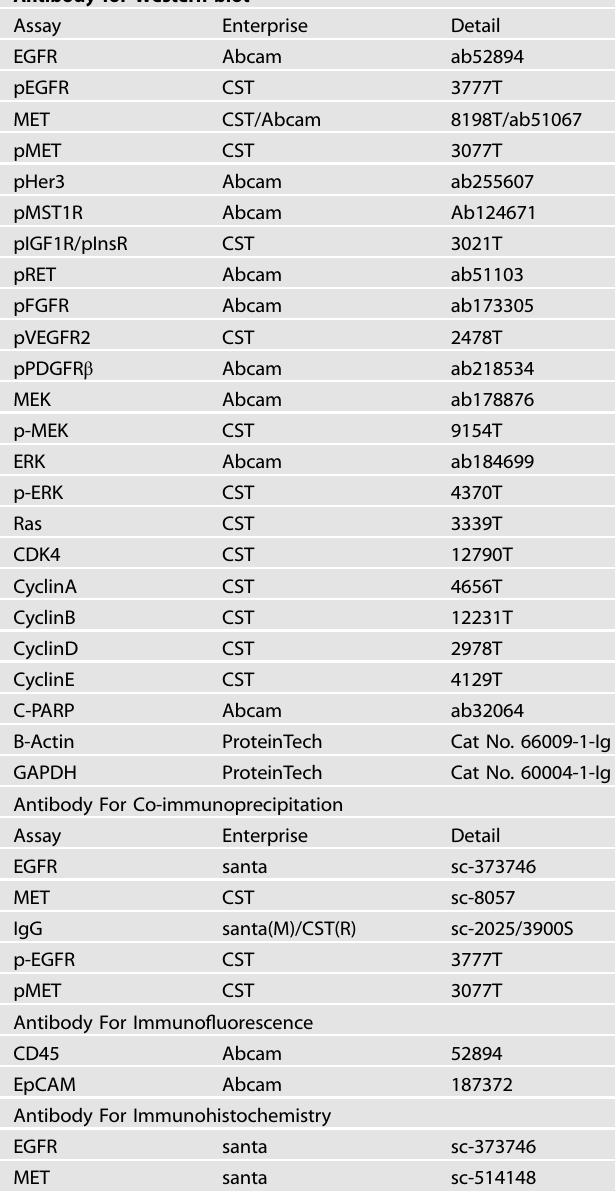
Table 3. Purchase source and catalog ID of antibodies used. Table 4. Clinicopathologic characteristics of HCC patients in cohorts for IHC and RTKs